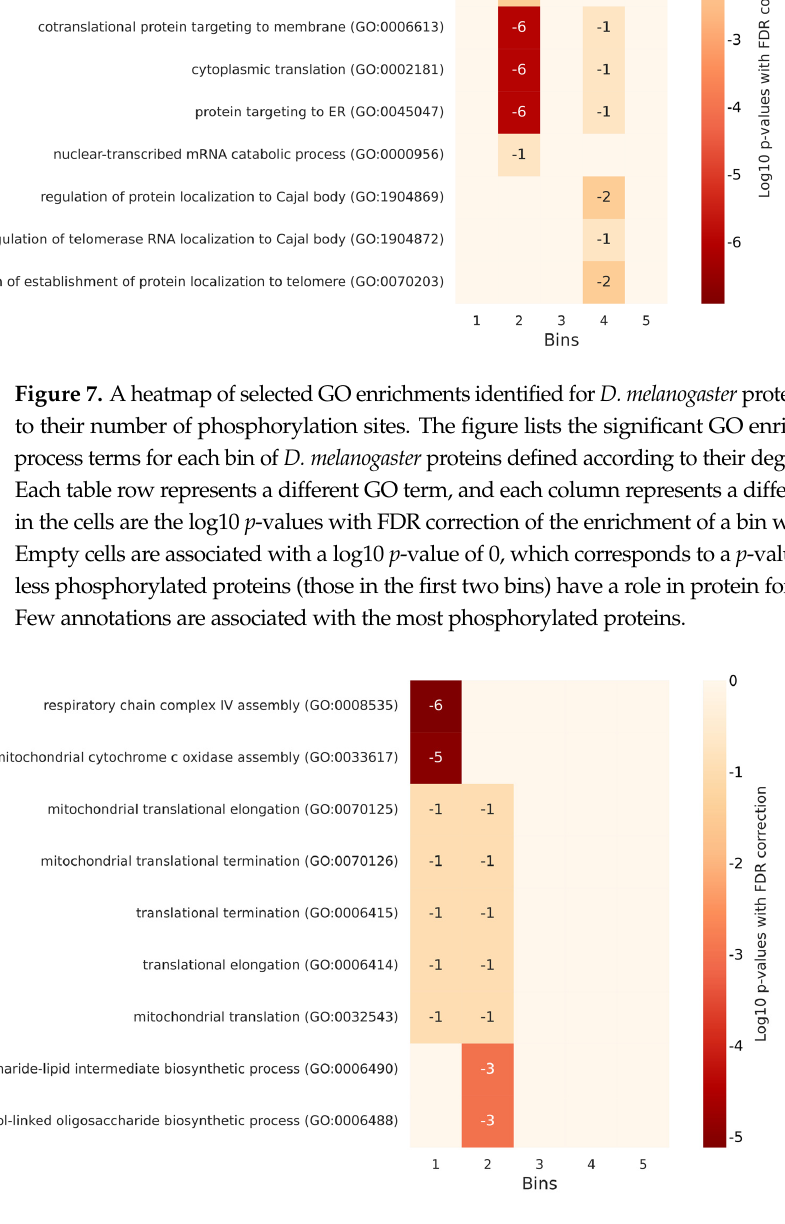
Figure 8. A heatmap of selected GO enrichments identified for S. cerevisiae proteins grouped by quintile based on their number of phosphorylation sites. The figure lists the significant GO enrich- ments by biological process terms for each quintile of S. cerevisiae proteins defined according to their degree of phosphorylation. Each table row represents a different GO term, and each column represents a different quintile. The numbers in the cells are the log10 p -values with FDR correction of the enrichment of a bin with a specific GO term. Empty cells are associated with a log10 p -value of 0, which corresponds to a p -value of 1. In the yeast, the less phosphorylated proteins (those in the first two quintiles) have a role in protein formation and transport. Oligosaccharide biosynthetic processes are associated with proteins in the second quintile, and no significant annotation are found for the most phosphorylated